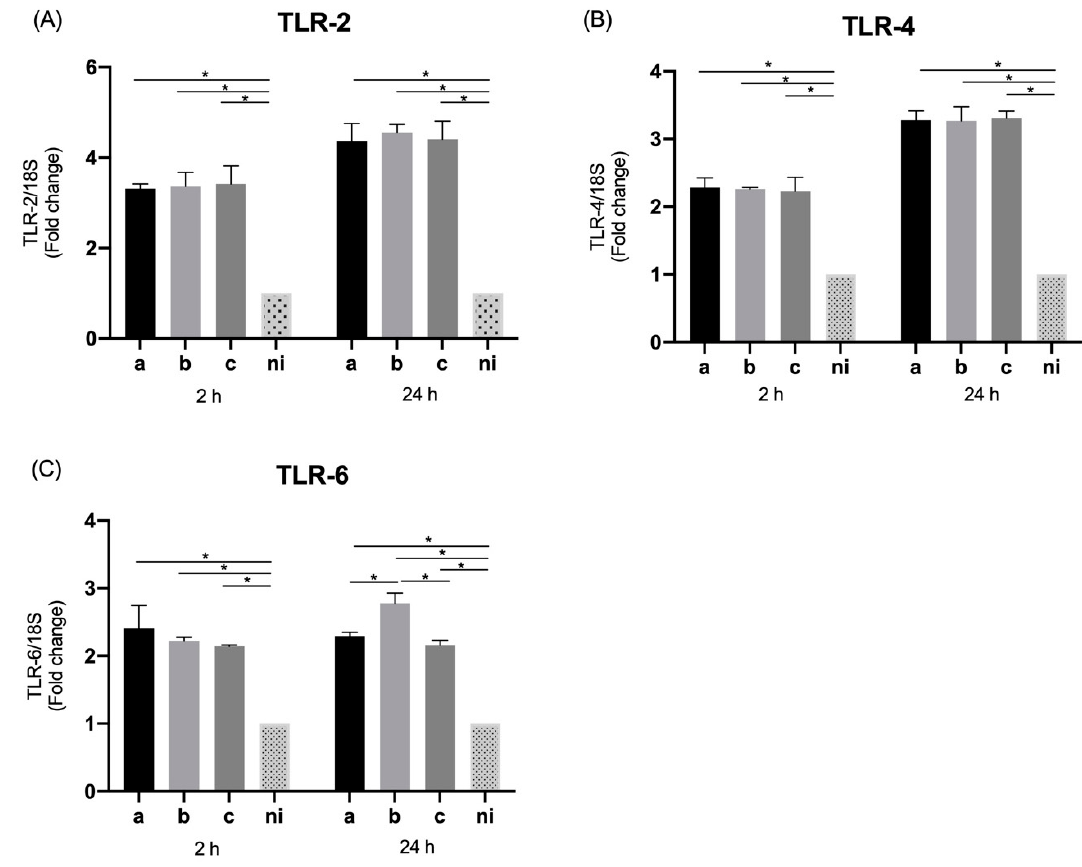
Figure 7. Toll like receptors (TLR) mRNA expression by A. actinomycetemcomitans -induced THP-1 human macrophages (ATCC ® TIB-202™). Expression in macrophages infected at a MOI = 10 2 with strains ATCC ® 43717 TM (serotype a), ATCC ® 43718 TM (serotype b), and ATCC ® 43719 TM (serotype c), 2 and 24 h after infection. For relative expression, mRNA expression in non-infected (ni) macrophages was considered as 1, as a reference for fold-change in expression using 18S rRNA expression levels as a normalizing endogenous control. Data are represented as fold-change means and standard deviation of three independent experiments performed in duplicate. ( A ) TLR-2, ( B ) TLR-4, and ( C ) TLR-6. Asterisks were used to indicate a value of p considered statistically significant (* p < 0.05).